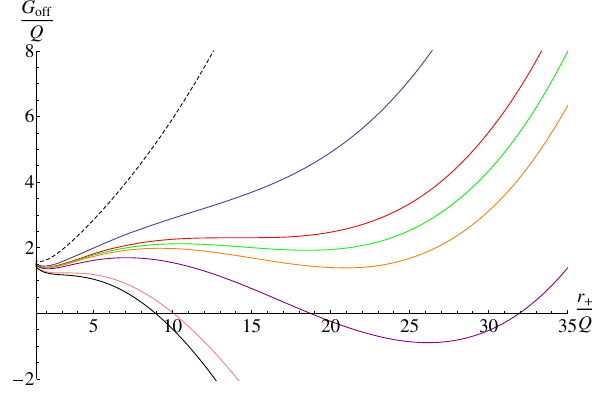
Fig. 8 Plots of the reduced off-shell Gibbs free energy G off / Q as a function of r + / Q under the different values of the temperature T of the thermal bath, for l / Q = 25. The dashed black, blue, red, green, orange, purple, pink, and black curves correspond to the reduced temperature T × Q = 0, 0 . 009, ≈ 0.0109 ( T min × Q ) , 0 . 0113, ≈ 0.0117 ( T deg × Q ) , 0 . 013, ≈ 0.0175 ( T max × Q ) , 0 . 019 . The extremal points of each curve refer to the black hole configurations of the corresponding temperature. For T = T max (or T = T min ), the local minimum and maximum of G off merge into an inflexion point